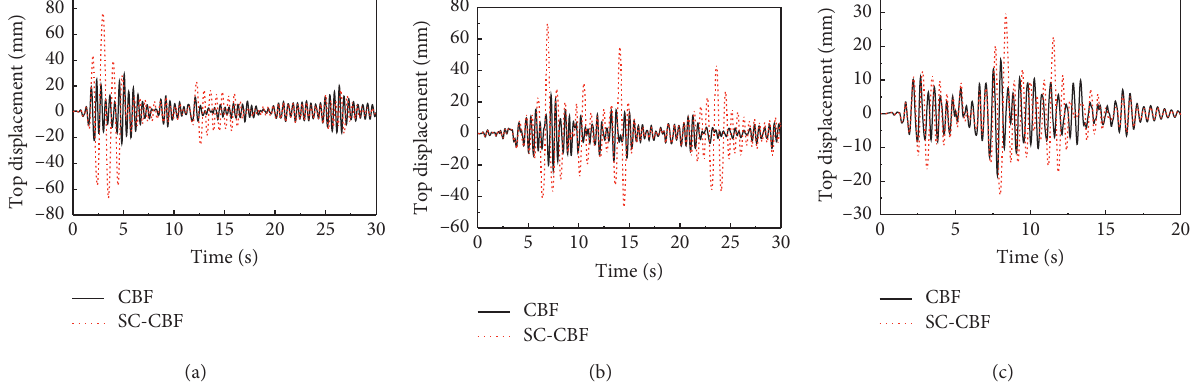
Figure 19: Top displacement versus time curves of the structure under extremely rare earthquake: (a) El Centro wave; (b) Taft wave; (c) artificial wave.